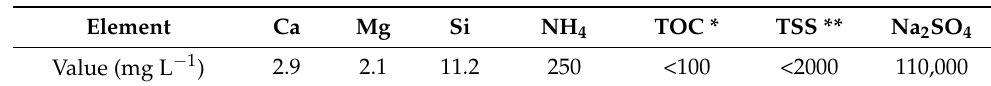
Table 2. Effluent